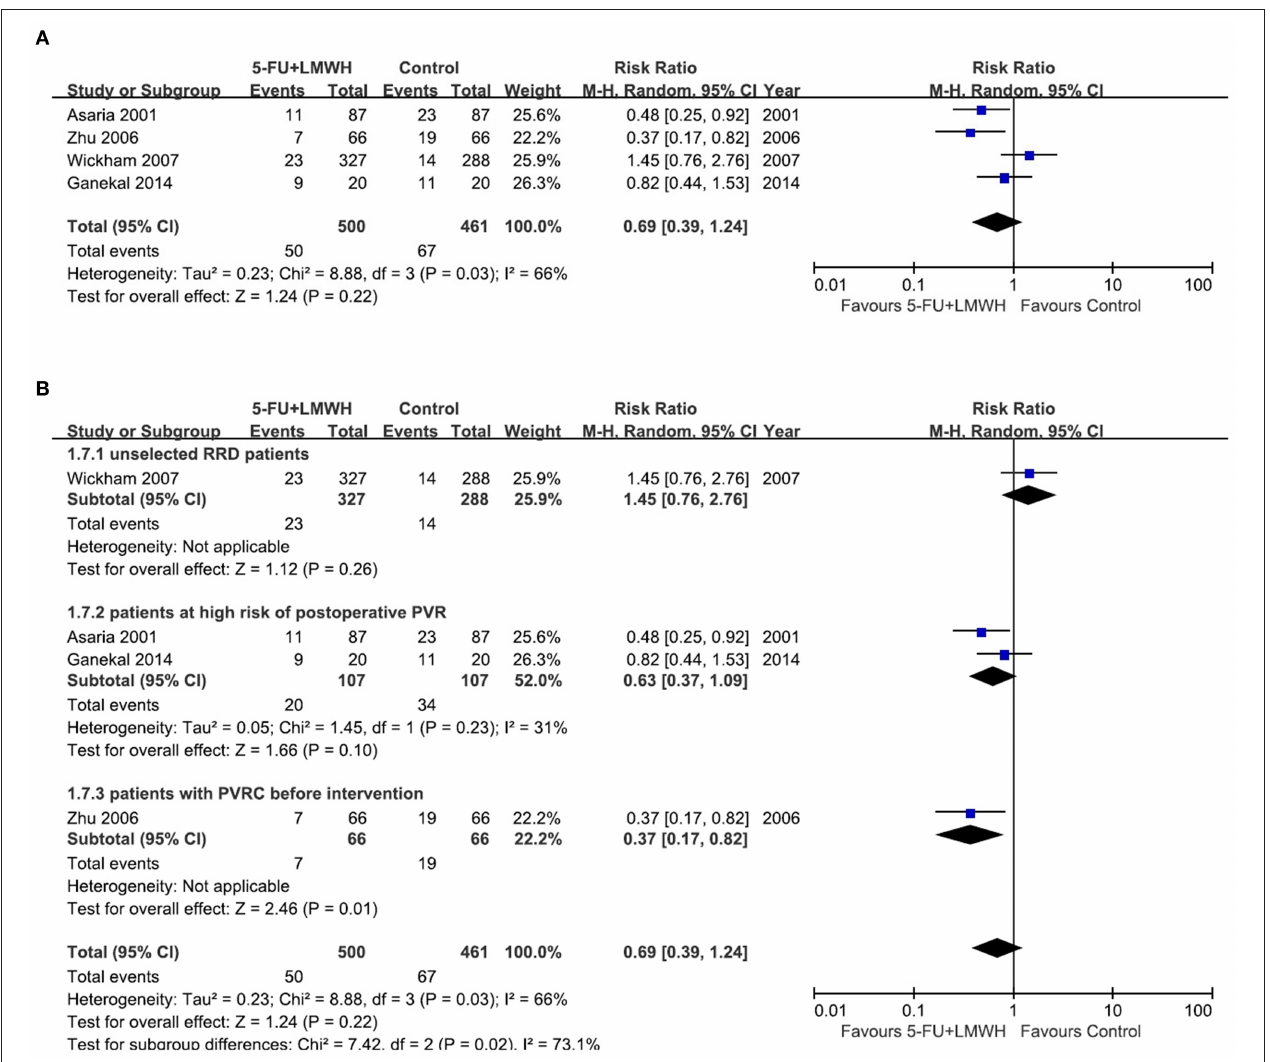
FIGURE 4 | Forest plots for the meta-analysis of postoperative proliferative vitreoretinopathy (PVR) occurrence. (A) Overall meta-analysis; (B) Subgroup analysis according to the preoperative PVRC ratio.